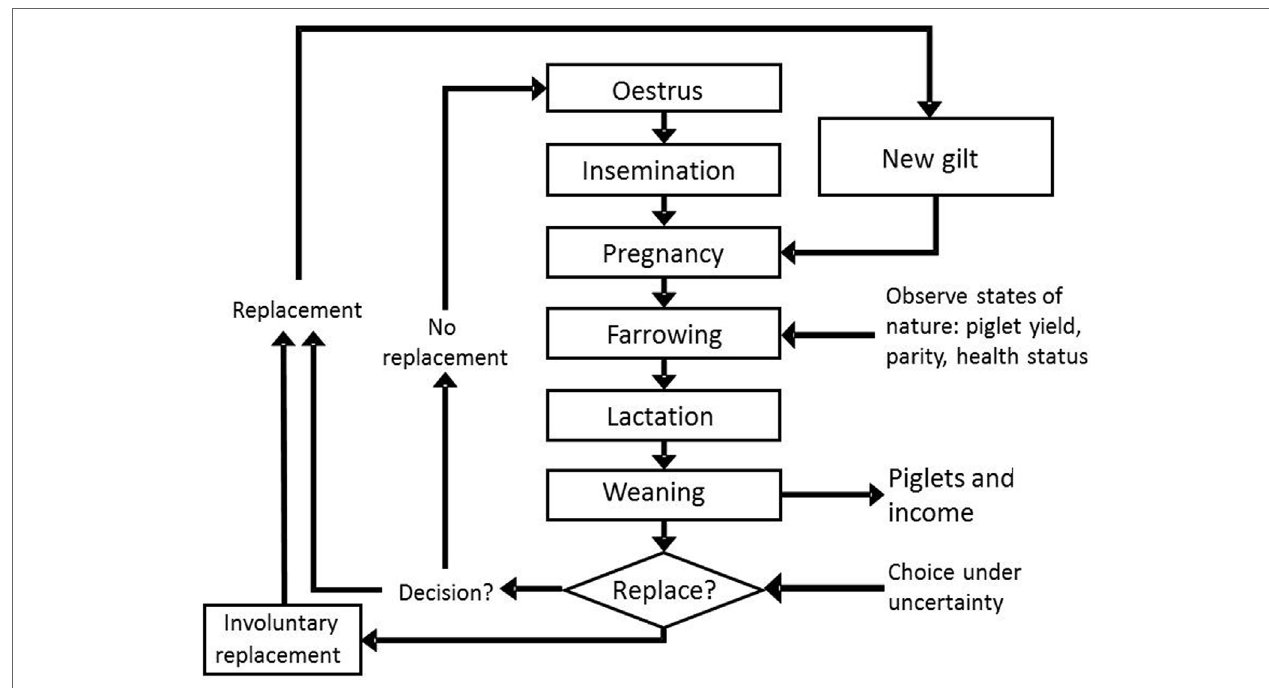
FigUre 2 | The production cycle of a sow and cash flows (revenues, costs) associated with these events, as simulated in the dynamic programming model.